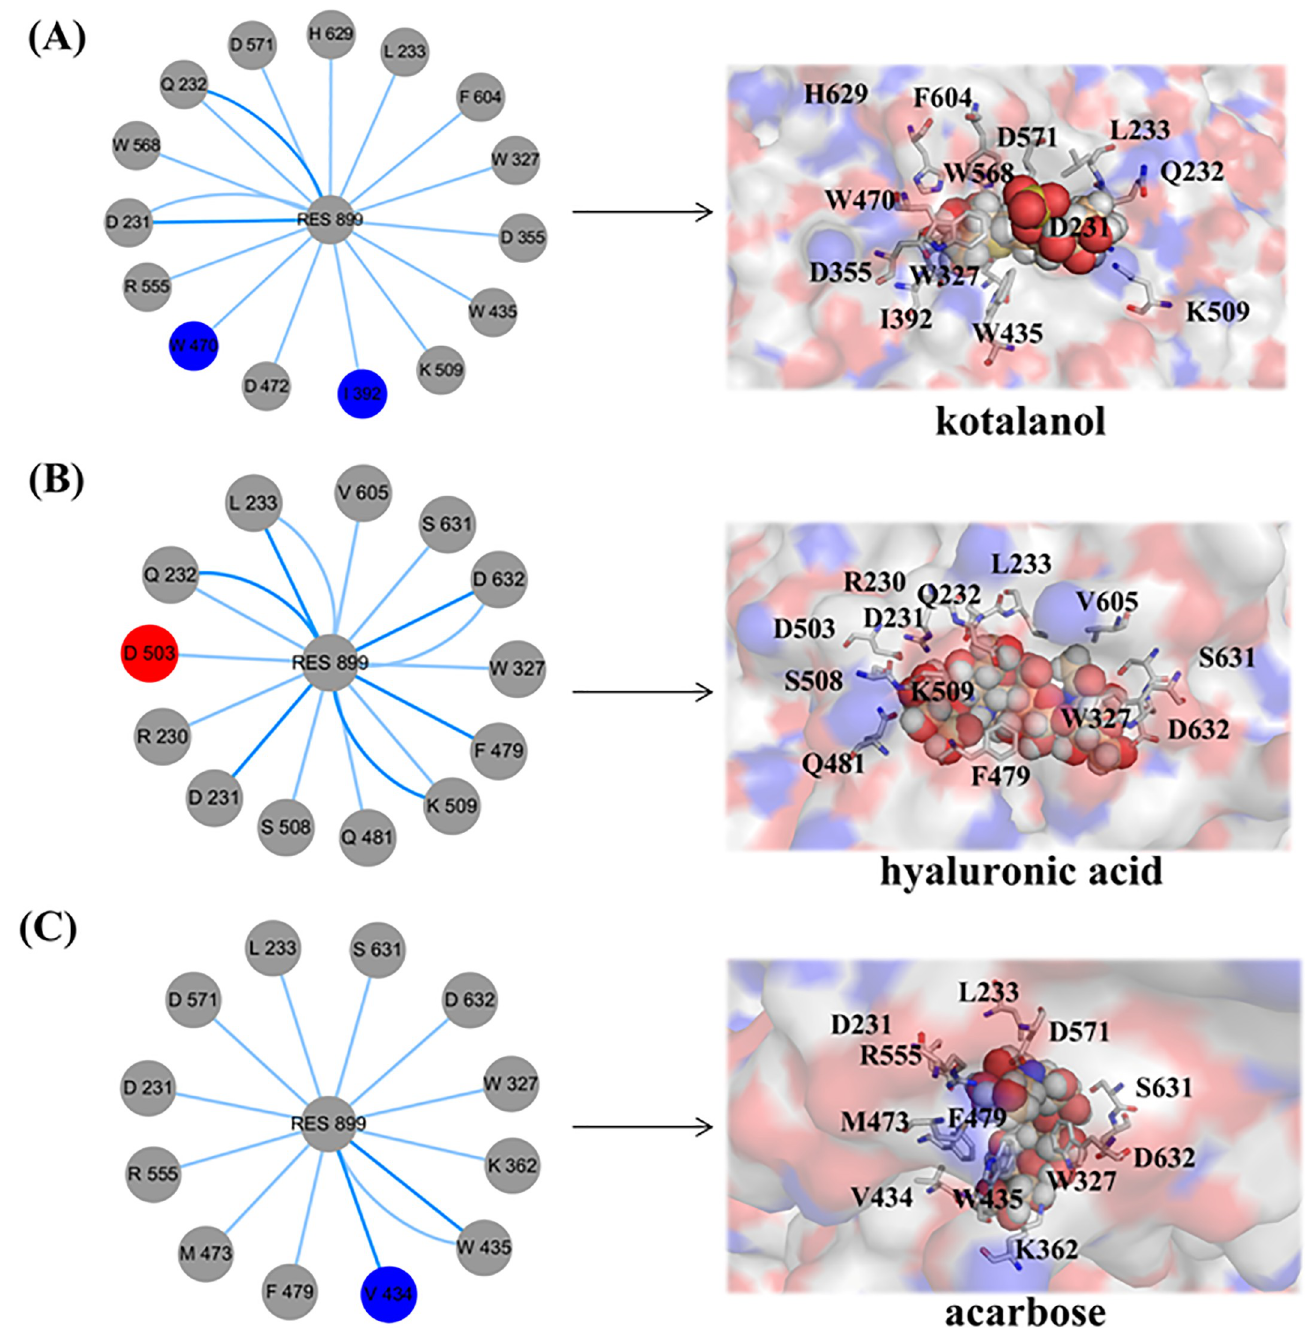
Fig 9. Subnetwork analysis of the protein − ligand interaction. (A) The subnetwork of SI-kotalanol. (B) The subnetwork of SI-HA. (C) The subnetwork of SI-